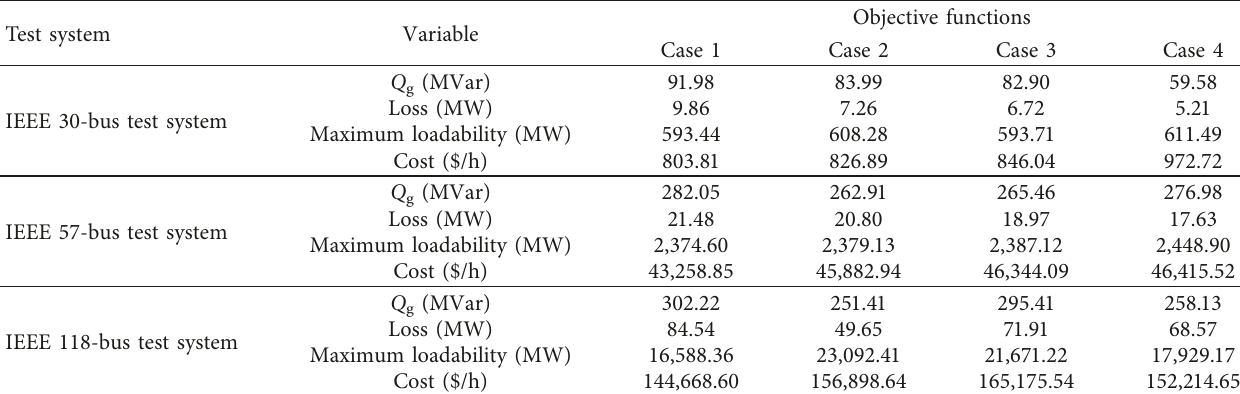
Table 4: System performance for line outage